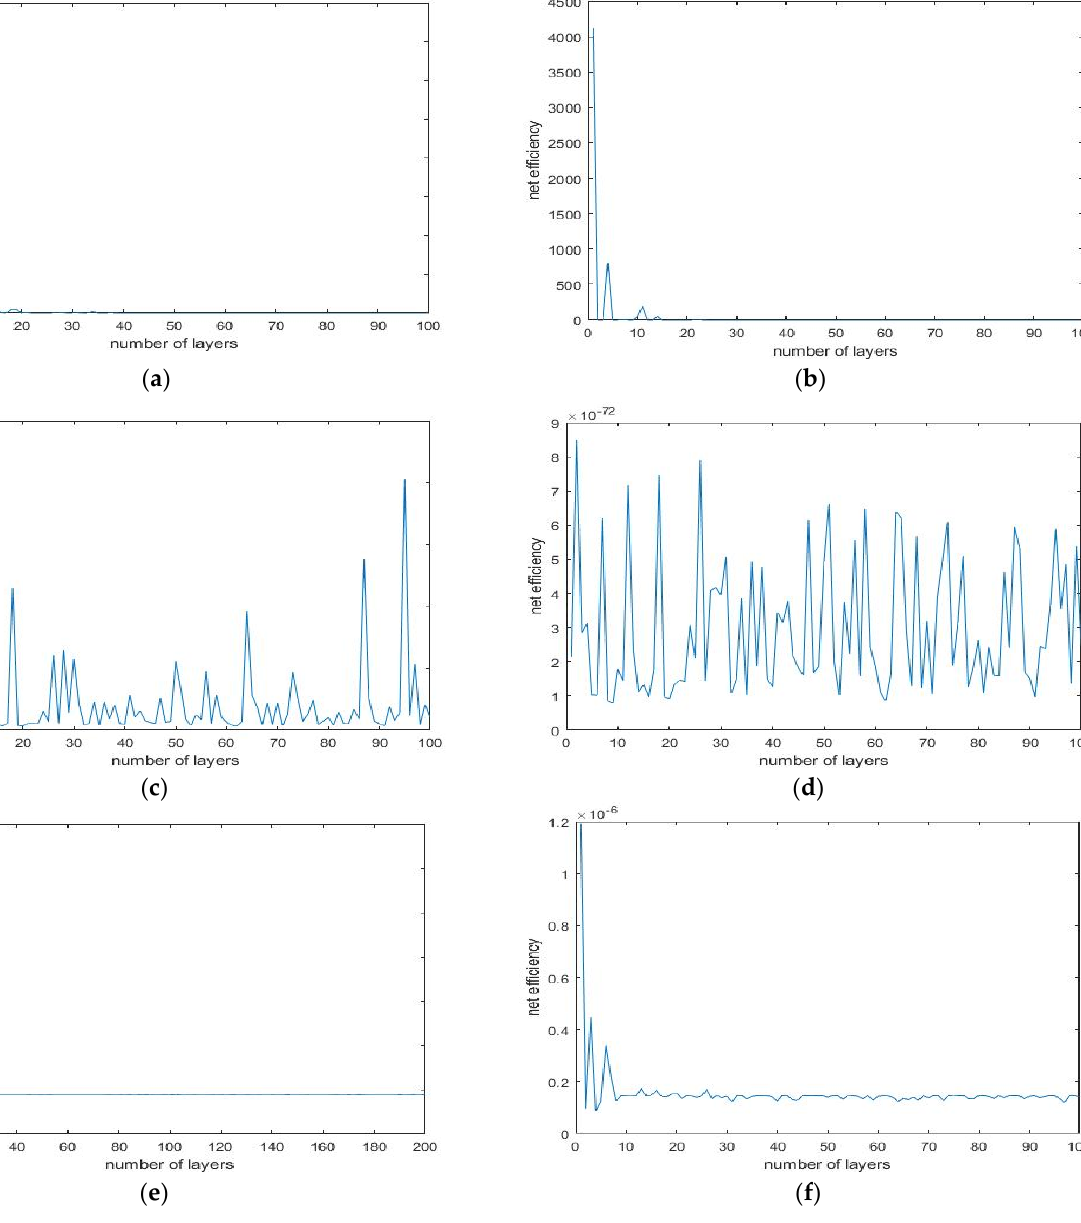
Figure 7. Efficiency of neural networks in approximating different functions with different numbers of training samples and one output neuron (k = 1). ( a ) y = 2 x 1 + 3 x 2 + 1, n = 2, m =